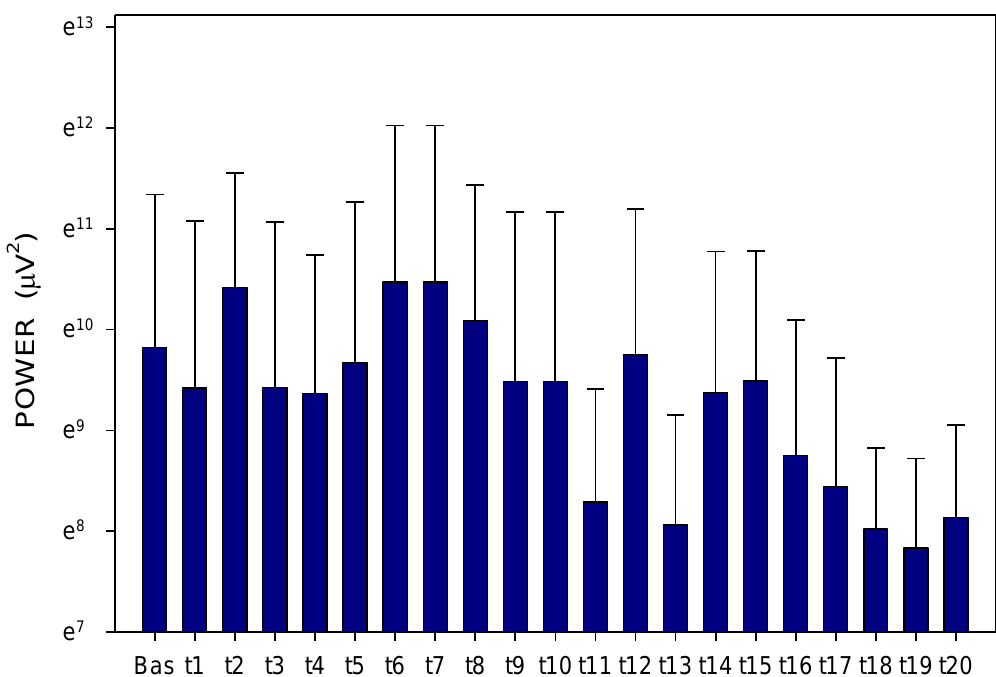
Figure 3. Electrogastrography. EGG power before and after a single intragastric administration of 24 mg galantamine (mean + standard deviation). Outliers omitted. Axis Y: natural logarithm scale. Explanatory note: Bas: 15-min basal recording before galantamine administration; t: 15-min study recordings after galantamine administration (t1: time interval between 0–15 min ... t20: time interval between 286–300 min).